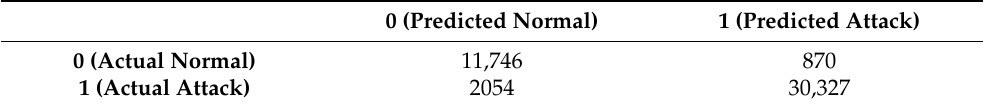
Table 4. Confusion matrix of SCG